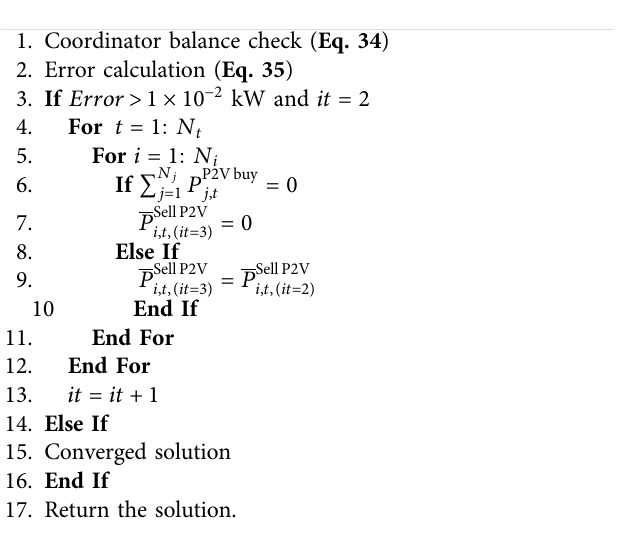
Algorithm 2. Application of Rule 2 ( Eq. 37 )